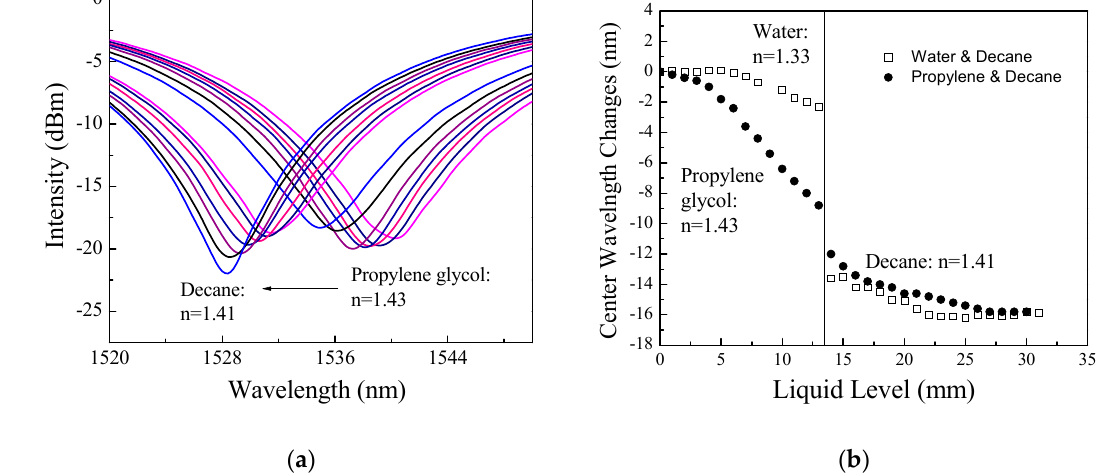
Figure 8. ( a ) Spectrum changes vs. simultaneous liquid interface and level changes (Experiment #5); ( b ) Resonant wavelength changes of LP07 vs. simultaneous liquid interface and level changes (Experiments #4 and #5).